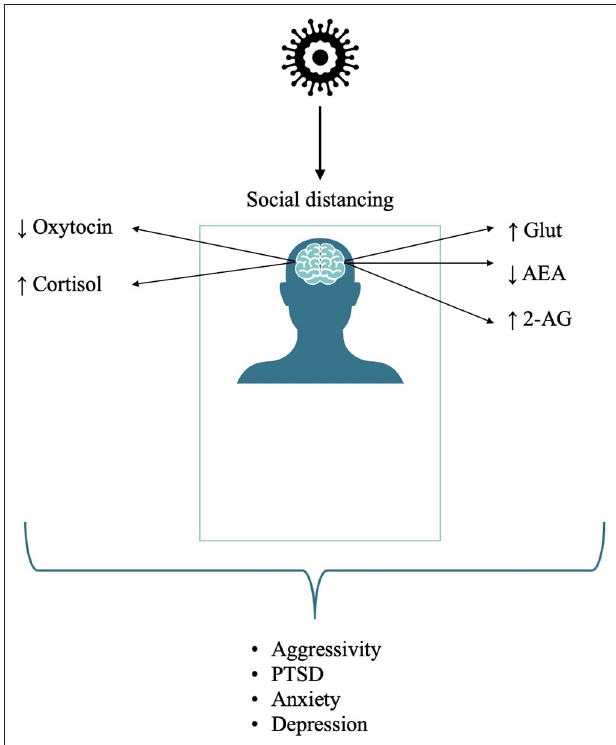
FIGURE 1 | Effects of isolation on neurocircuitry and related detrimental mental health